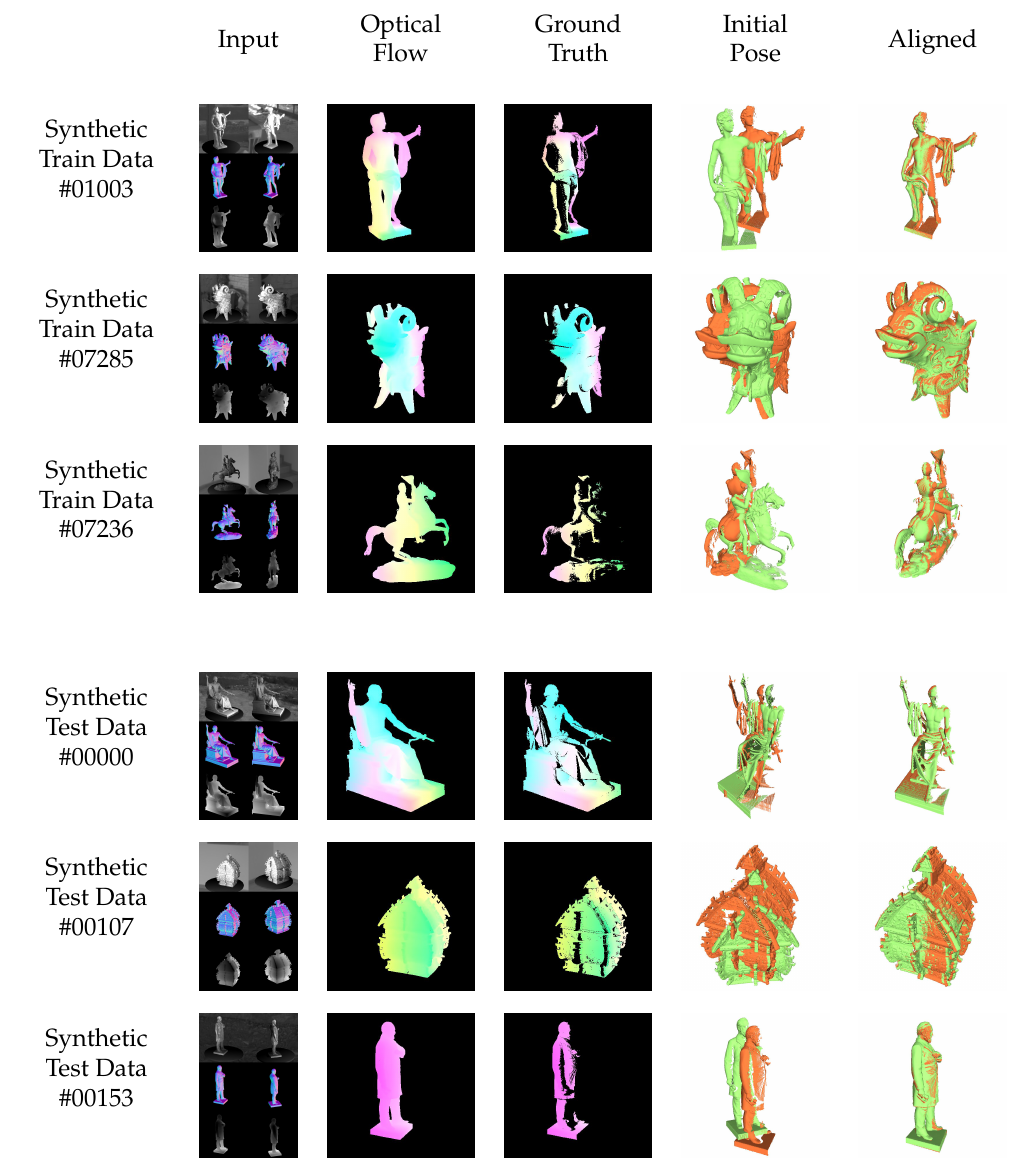
Figure 13. Qualitative results of the proposed method on training (top 3 rows) and test (bottom 3 rows) data of the synthetic consistent light dataset. The situation of consistent light represents the standard case, where, for example, the camera moves through a static scene with static light sources. The brightness assumption is usually not violated. The network generalizes well from known training to unknown test